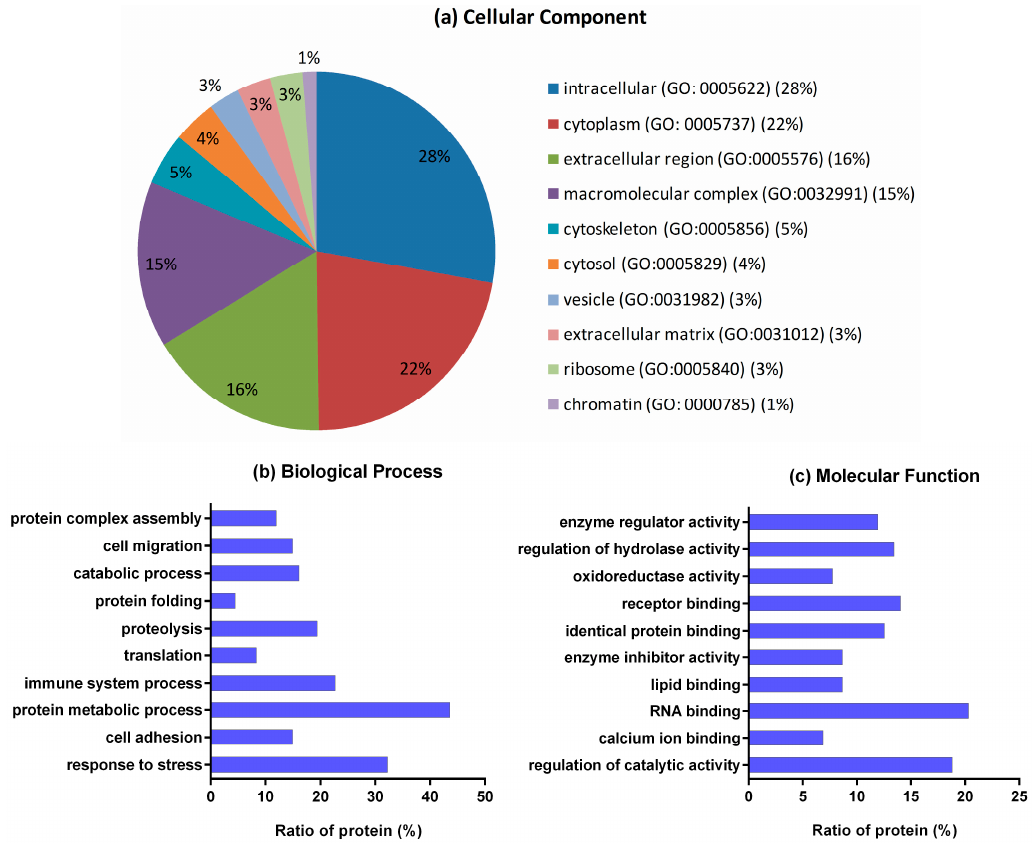
Figure 4. Gene Ontology (GO) analysis of Buffalo follicular fluid (BFF). ( a ) pie chart showing the percentage of cellular component; ( b ) histogram showing the ratio of protein involved in biological process; ( c ) histogram showing the ratio of protein involved in molecular function. Table 2. The KEGG pathway analysis of BFF proteins